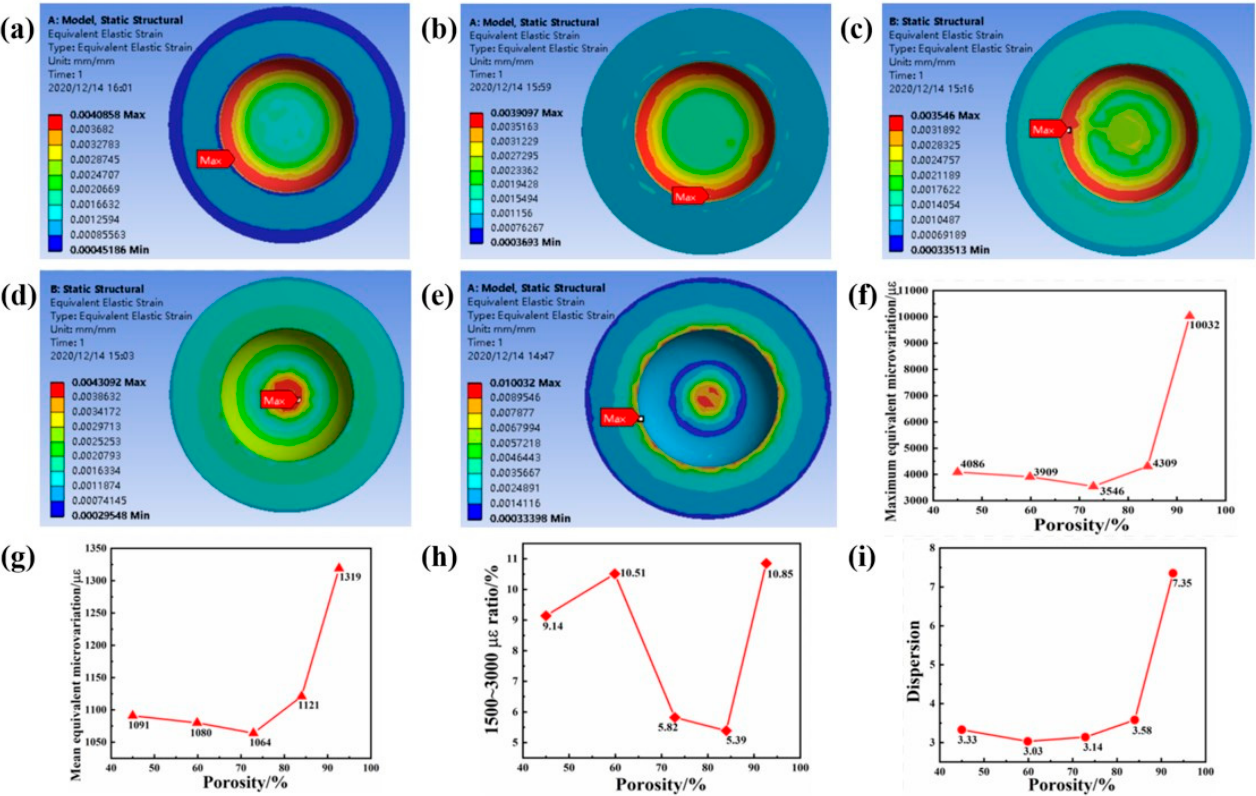
Figure 8. ( a – e ) Porosity 45–92.62%, equivalent strain cloud diagram of cancellous bone under 200 N compressive stress, ( f ) maximum equivalent strain, ( g ) average equivalent strain, ( h ) proportion of 1500–3000, ( i ) effect variation dispersion.